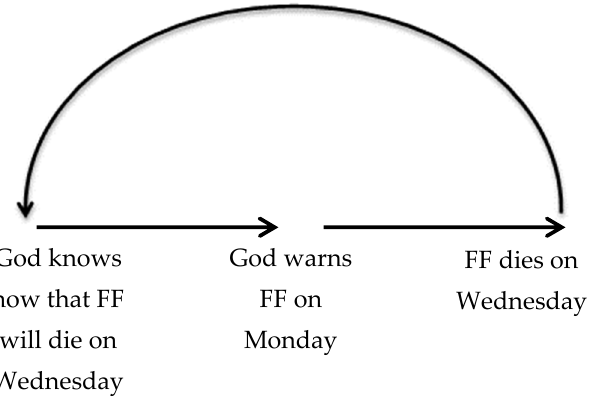
Figure 1. Divine foreknowledge in a causal loop (arrows denote causation).